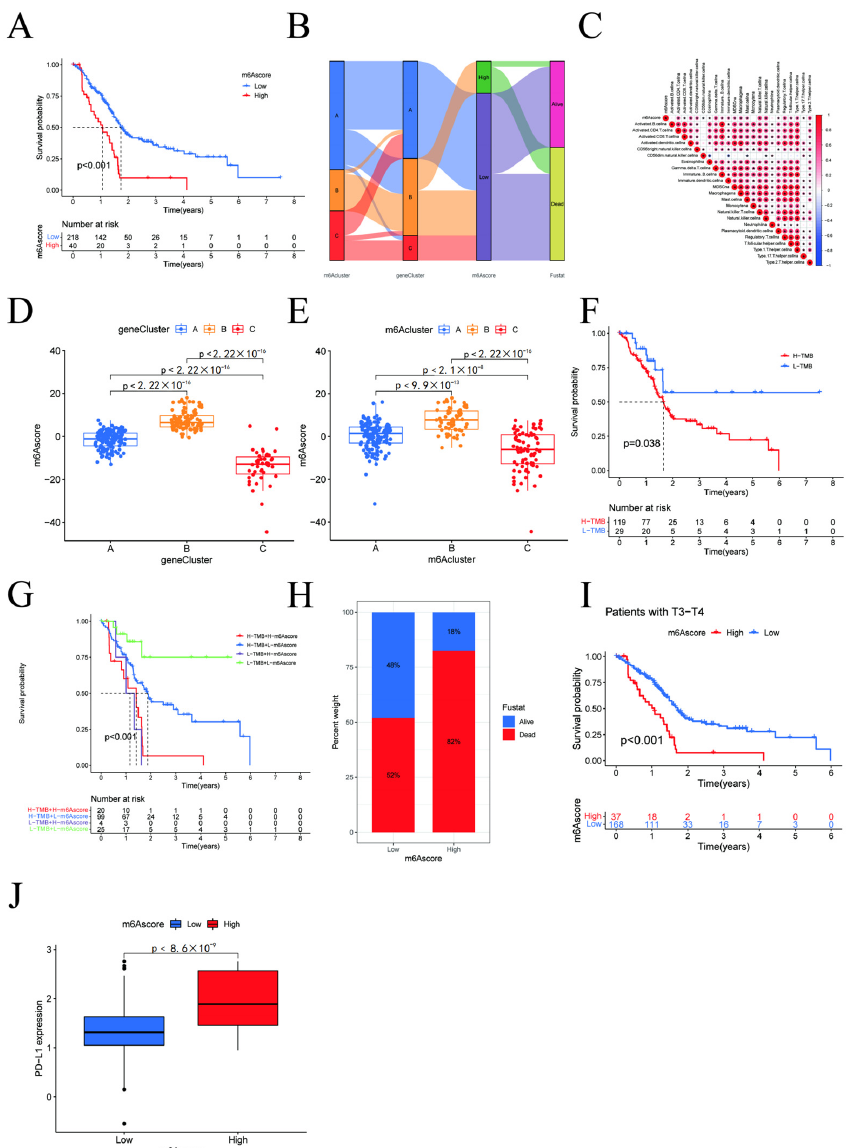
Figure 5. ( A , H ) Survival analysis of m6Ascore; ( B ) Alluvial plots; ( C ) Immune correlation analysis; ( D , E ) Expression of m6A score for different m6A types; ( F ) Survival analysis for different TMB group; ( G ) Tumor mutation load combined with different m6A score of pancreatic cancer related to survival; ( I ) Survival related to different disease stages; ( J ) PD-L1 gene expression with different m6A scores.